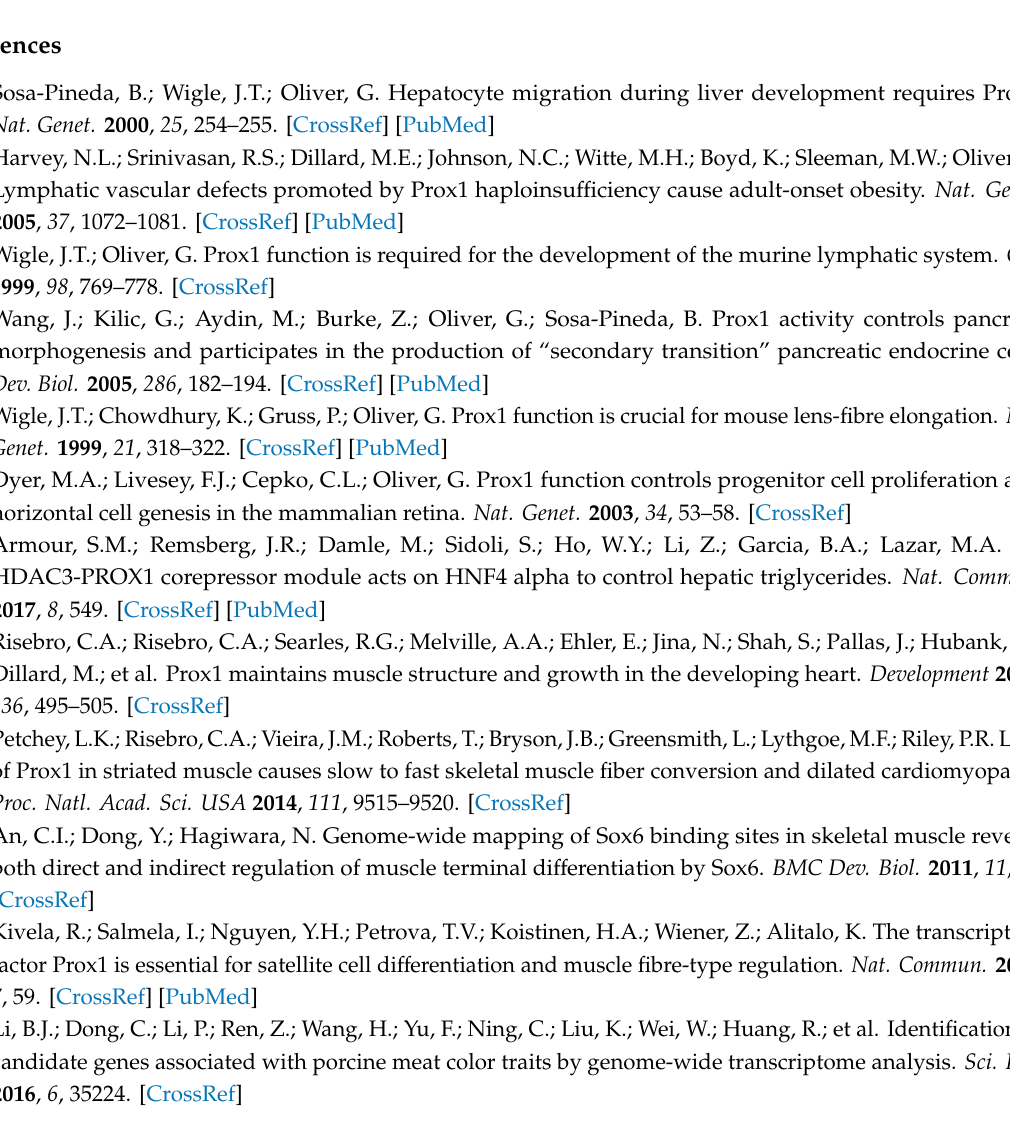
di ff erent pig breeds. Figure S1: Alignment of Prox1 CDS nucleotide sequences derived from di ff erent species. Figure S2: Alignment of Prox1 protein sequences of CDS derived from di ff erent species. Figure S3: Genotypic gel electrophoresis pattern using the PCR-RFLP